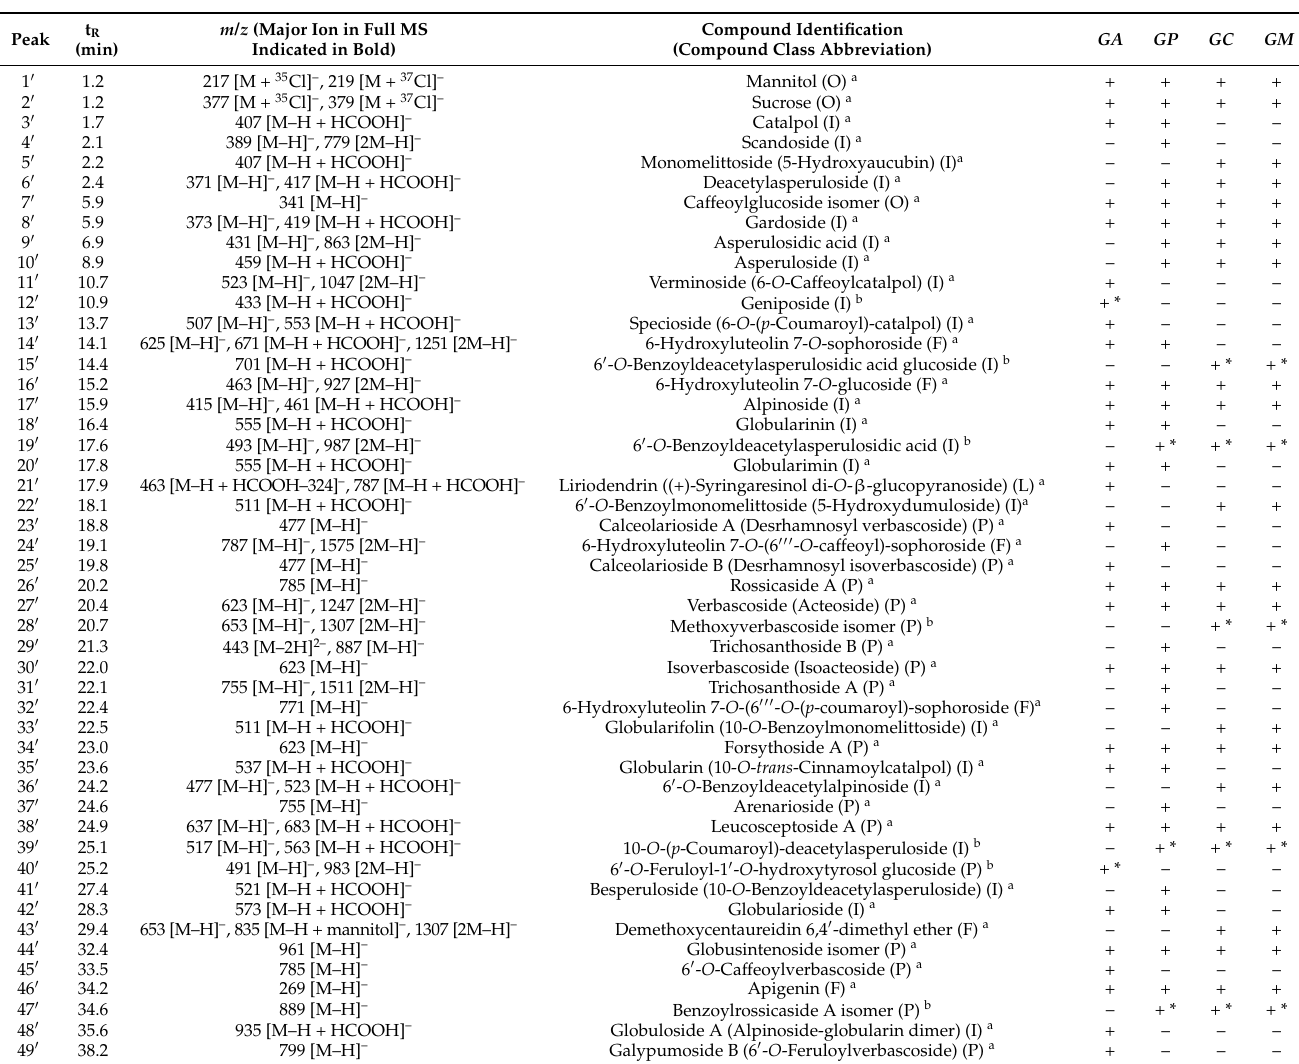
Table 4. LC-MS profile of methanolic aerial parts extracts from G. alypum ( GA ), G. punctata ( GP ), G. cordifolia ( GC ) and G. meridionalis ( GM ) obtained by Soxhlet